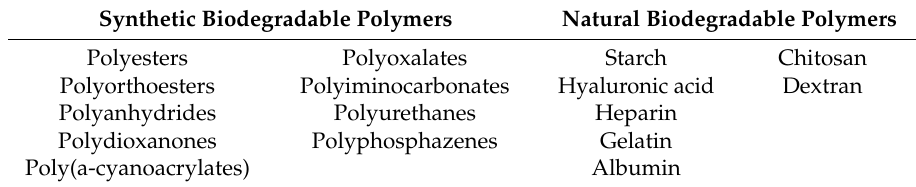
Table 1. Synthetic and natural biodegradable polymers used as drug delivery vehicles adapted from [36].